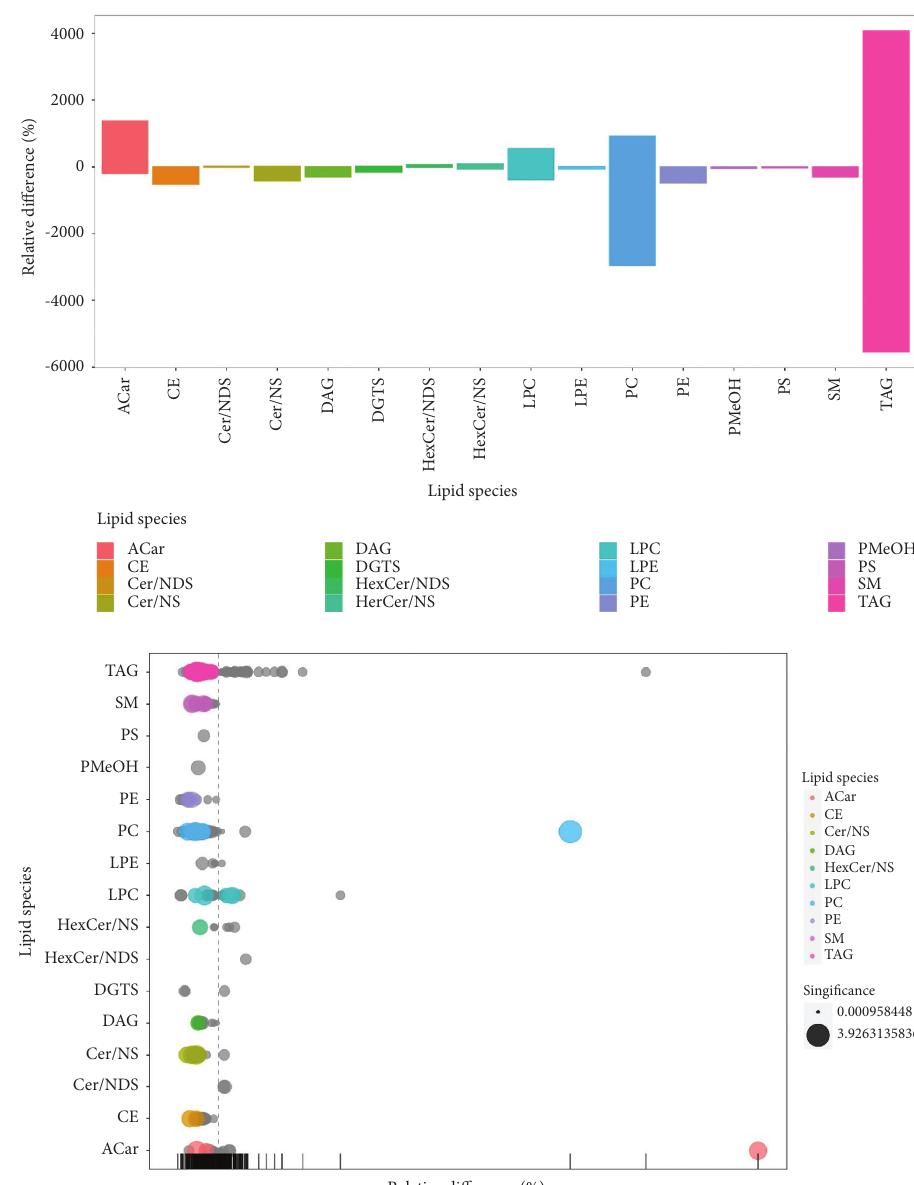
Figure 5: Histogram and bubble plot of lipid group in high-fat feed group-high-dose reconstituted rice group (Positive ion mode). Note: take Figure 5 as an example: the different colors in the bar graph of lipid groups represent the different lipid metabolizing substances screened out respectively. The vertical coordinate in the graph indicates the relative percentage change of each lipid metabolizing substance in that assay group. If its value is zero, it indicates that the substance is present in the same amount in both groups, if its value is positive, it indicates that the substance is present in a higher amount in the high lipid feed group, and if its value is negative, it indicates that the substance is present in a higher amount in the high dose reconstituted rice group. The horizontal coordinates of the lipid group bar graph indicate the classification information of lipids. A point in the lipidome bubble plot and represents a lipid metabolite. The size of the dot represents the P -value of the t -test (taken as the negative of the logarithm with a base of 10), with larger dots representing smaller P -value values. Gray dots indicate non-significantly different lipid substances for P > 0 . 05, and colored dots indicate significantly different lipid substances for P < 0 . 05. The horizontal coordinates in the graph represent the relative percentage change in the content of each lipid metabolite for the group comparison. The vertical coordinates in the figure indicate the classification information of lipids. The black line segments at the bottom demonstrate the density of metabolite distribution (one segment represents one